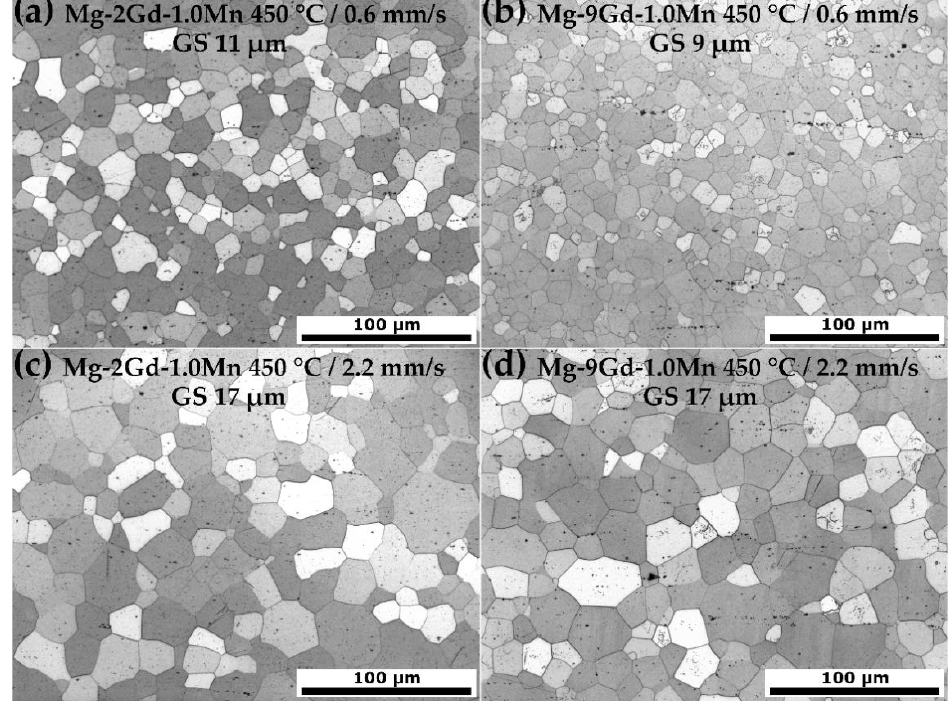
Figure 3. Light optical micrographs with average grain size (GS) of Mg-xGd-1Mn (x = 2 and 9 wt.%) with respect to extrusion speed (extrusion direction horizontal).